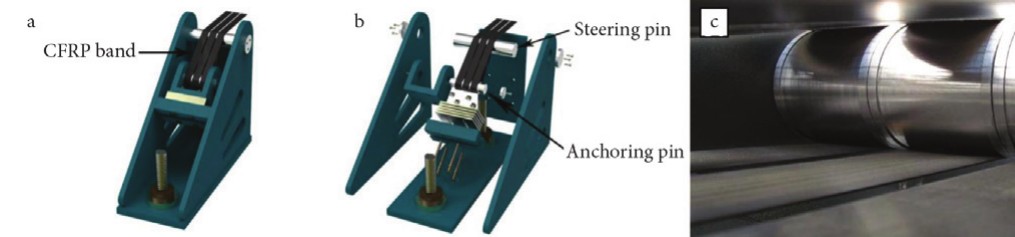
Fig. 2. Pin-loaded anchorage system (Liu et al . 2015): a – assembled; b – exploded schemes; c – internal view